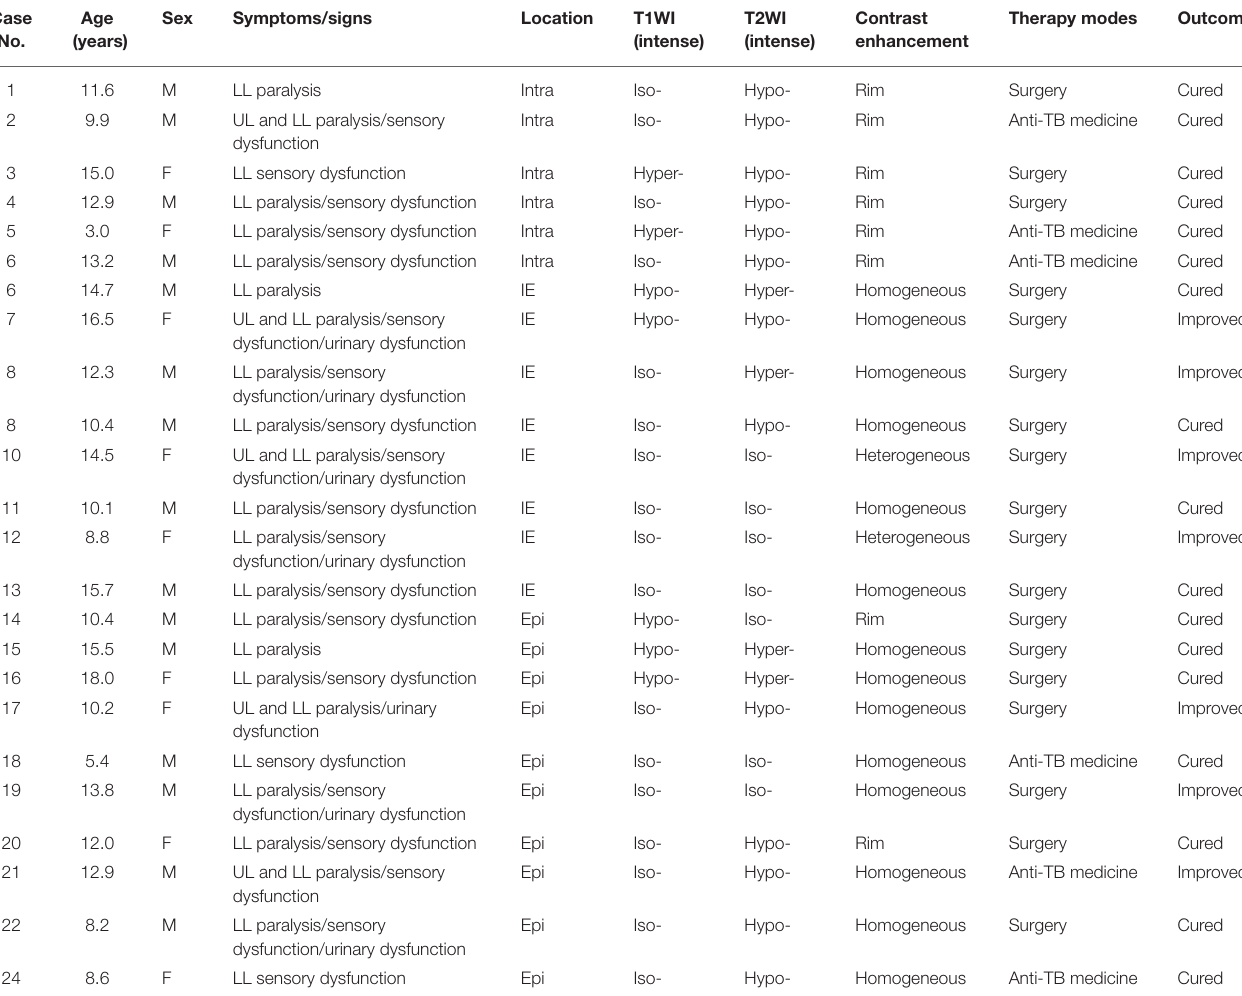
TABLE 1 | Clinical and MRI data of 24 patients with intraspinal tuberculoma. Case